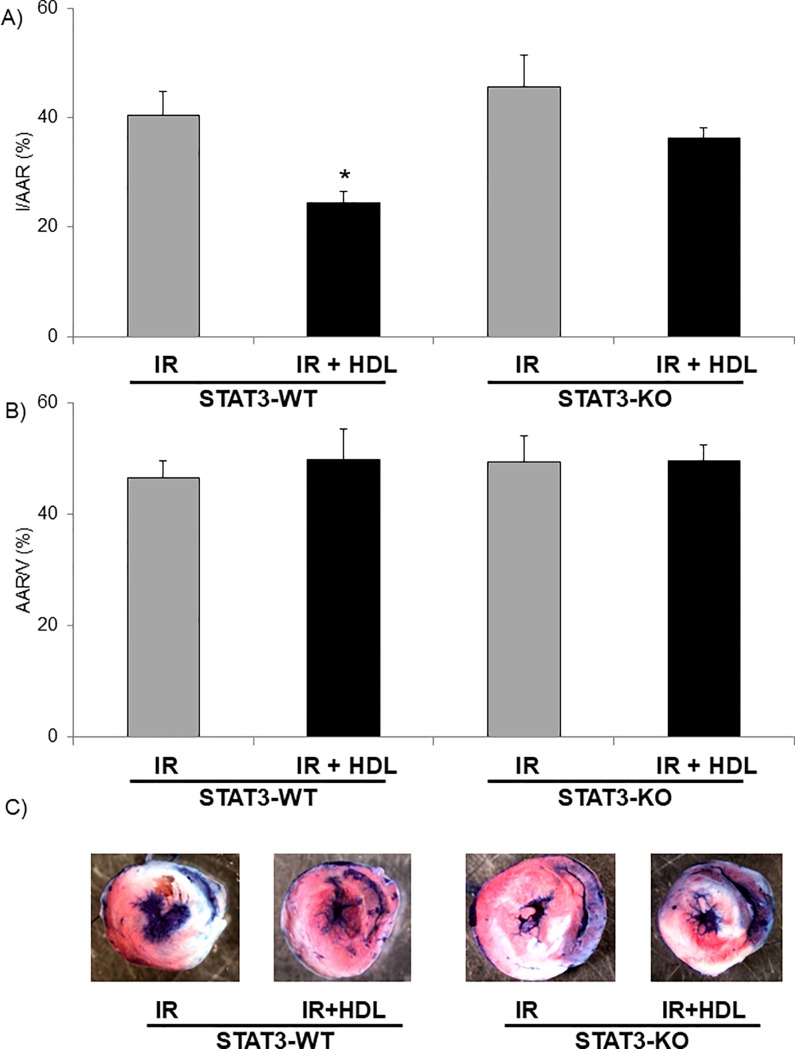
In vivo HDL protects the heart from IR injury via STAT3 activation.Mice were submitted to LAD occlusion for 45min and hearts were reperfused for 24h. Mice were injected or not (IR) with HDL (HDL) one minute before reperfusion. A) Quantification of infarct size (I) expressed in % of area at risk (AAR). B) Quantification of AAR per ventricle surface (V). C) Representative images of TTC stained middle heart sections of control or treated mice. Data are mean ± SEM, n = 6–8, *: p<0.05 vs IR.